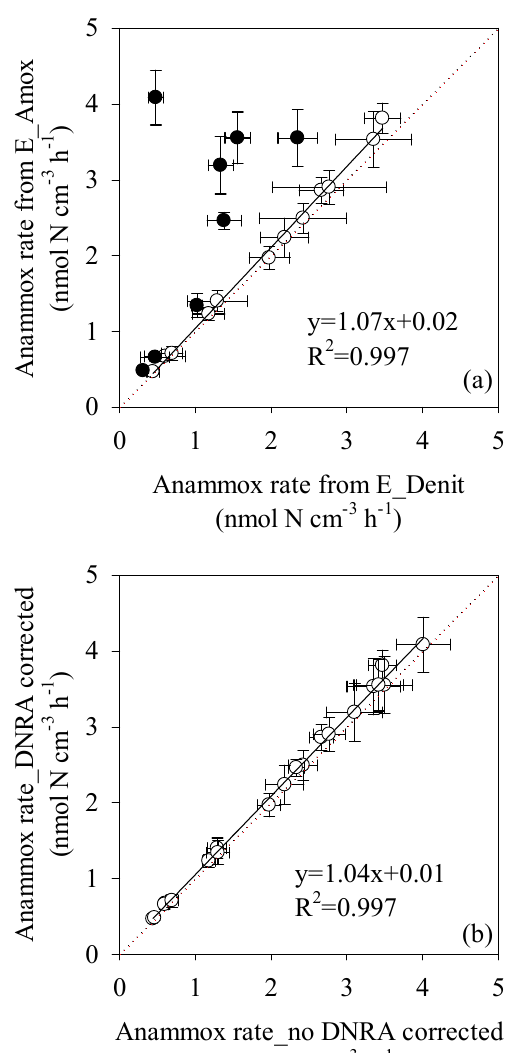
Fig. 8. Comparison of anammox rates from E_Denit and E_Amox (a) and DNRA effects on the anammox rate in E_Amox (b) . The black dot represents the anammox rate calculated from E_Denit derived from the original F N since we can not calculate F ∗ F ∗ >F N according Eq. (4). The anammox from E_Denit is the rate only after nitrate release correction.